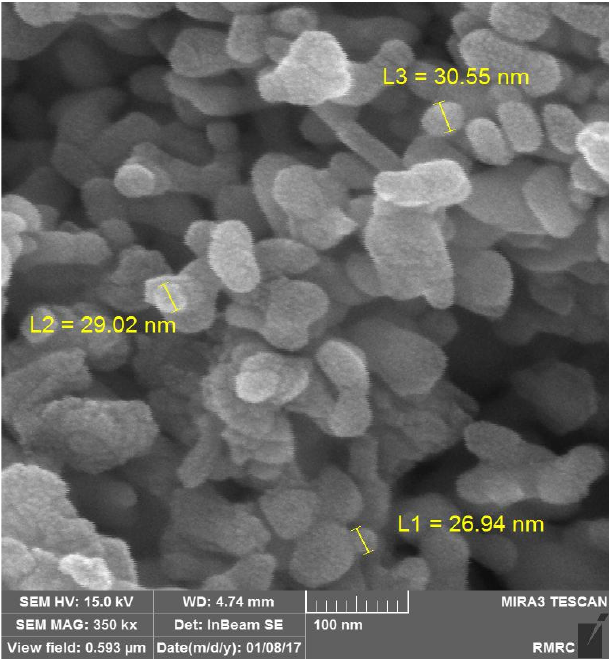
Fig. 3. SEM image of the synthesized CdO NPs.